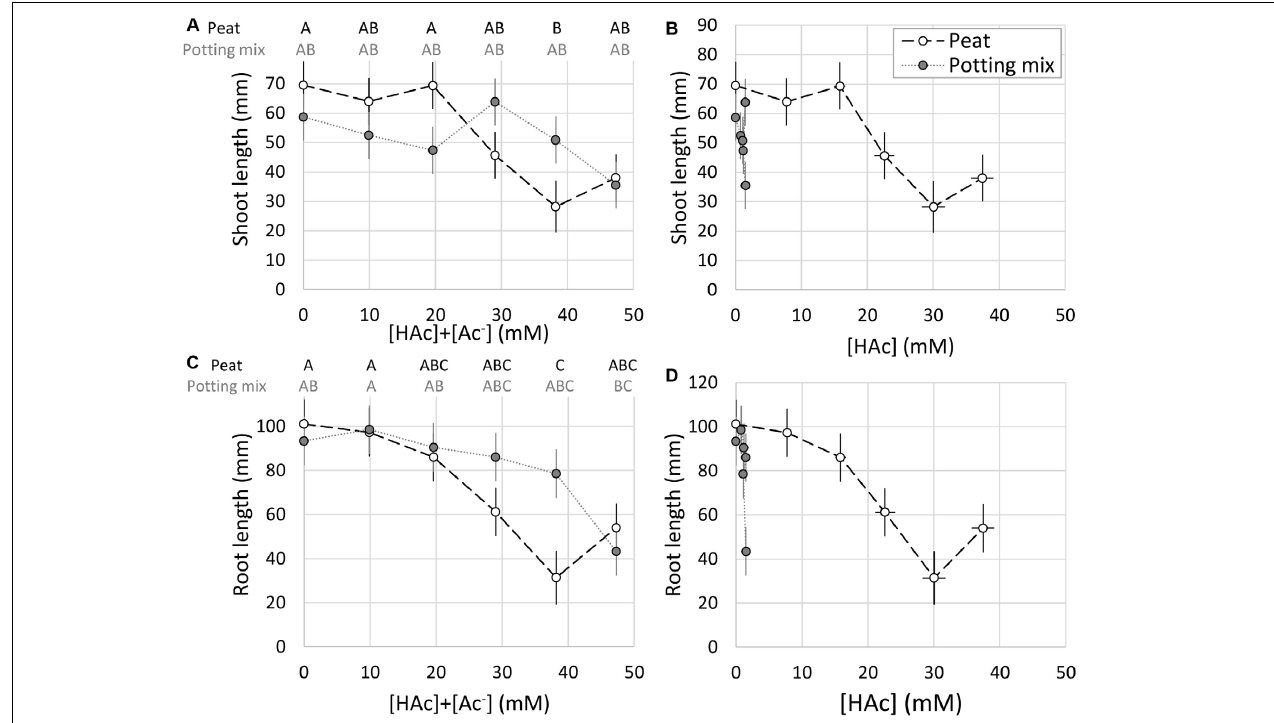
FIGURE 5 | Total ([HAc] + [Ac − ]) (A , C) and undissociated ([HAc]) (B,D) acetic acid concentration impacts on seedling root (C,D) and shoot (A,B) growth (mean ± 1 standard error of the mean) in peat and potting mix growth media with contrasting pH. Significant differences between treatments ( p < 0.05) are marked with contrasting letters ( A , C ; blocked factorial ANOVA; Tukey pairwise comparison; n = 6).